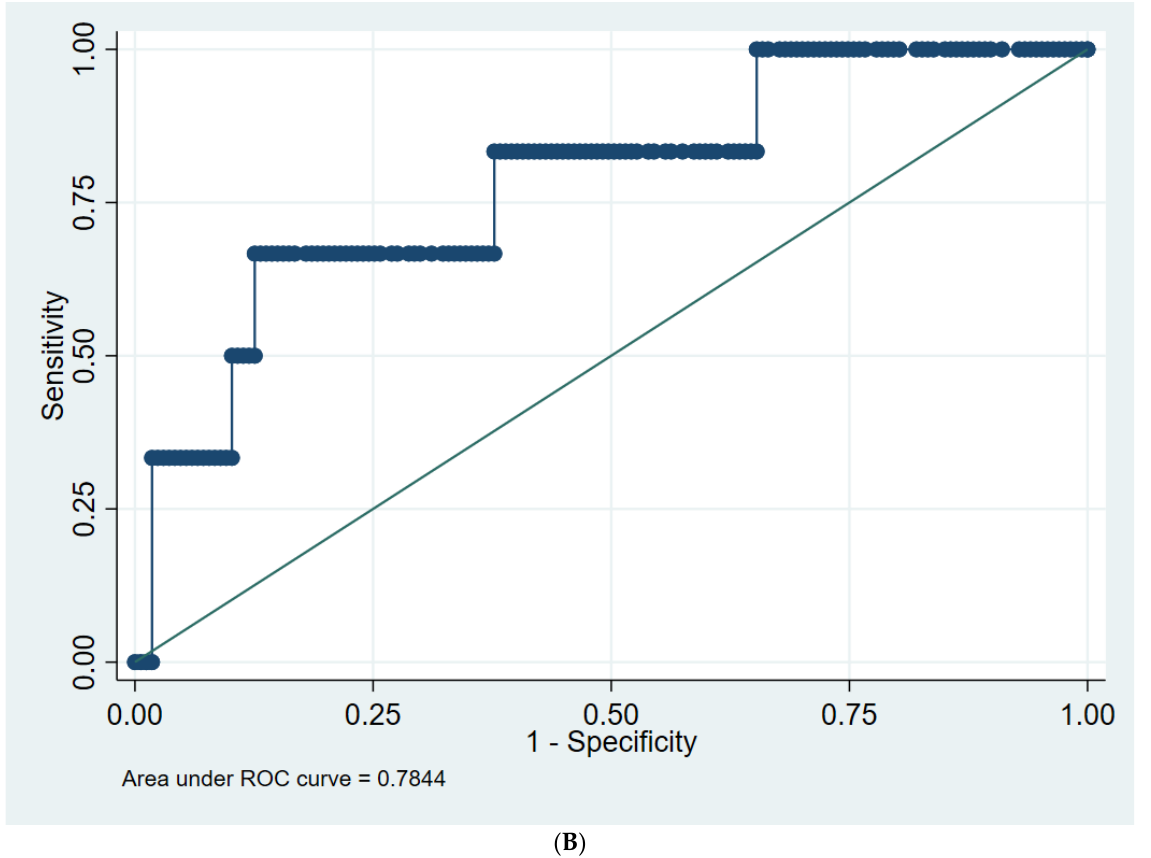
Figure 2. ( A ) ROC curve for CRP D4 in predicting CAP survival; ( B ) ROC curve for CRP D7 in predicting CAP survival.